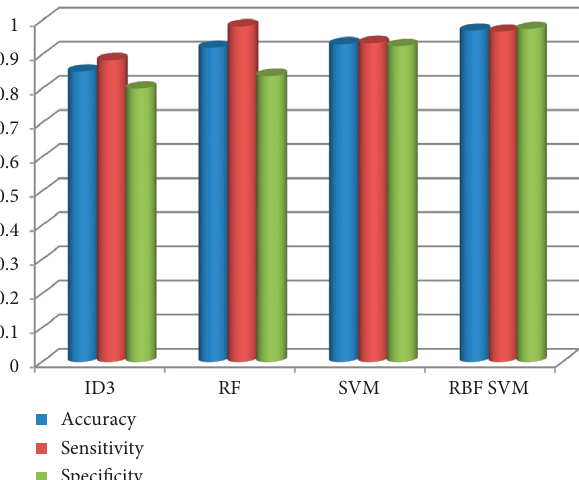
Figure 5: Performance of machine learning techniques for plant leaf disease